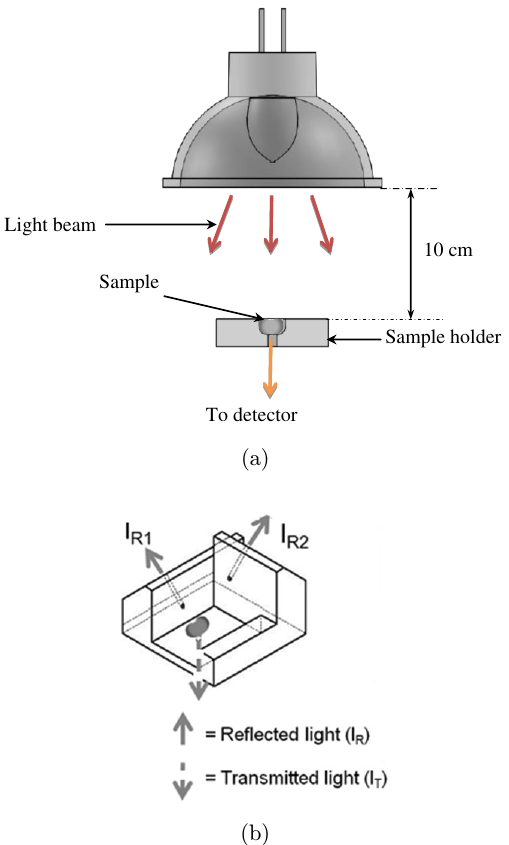
Fig. 1. (a) Mung bean holder showing light source and (b) isometric view of mung bean holder uniquely designed to collect both re°ected and transmitted